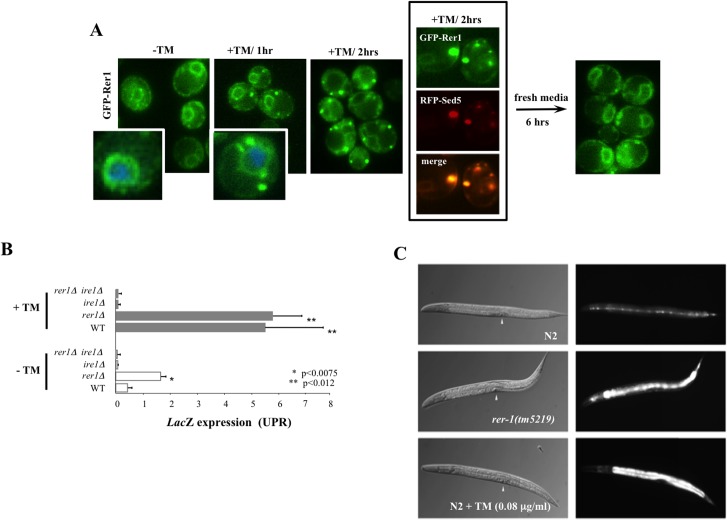
Induction of UPR in yeast and worm rer1 mutants.
A. Live cell imaging of GFP-Rer1 expressed from a centromeric plasmid in yeast rer1Δ mutants treated with DMSO or after exposure 0.2 μg/ml TM. GFP-Rer1 localizes to perinuclear ER in untreated cells and redistributes to Golgi in cells treated with TM. Insets show cells counterstained with DAPI. Boxed images denote GFP-Rer1 colocalization with Golgi resident RFP-Sed5. GFP-Rer1 relocalizes to ER following a 6 hour release into fresh media. B. The in situ expression of LacZ from a KAR2 promoter after a 2 hour exposure to DMSO or 0.2 μg/ml TM. Data represent means ± s.e.m. (n = 3). C.
hsp-4::gfp expression in wild type, rer-1(tm5219) or TM-exposed adult hermaphrodites at 20°C. Background fluorescence in untreated N2 is due to basal expression of the GFP reporter in seam cells. Arrowheads denote vulva.